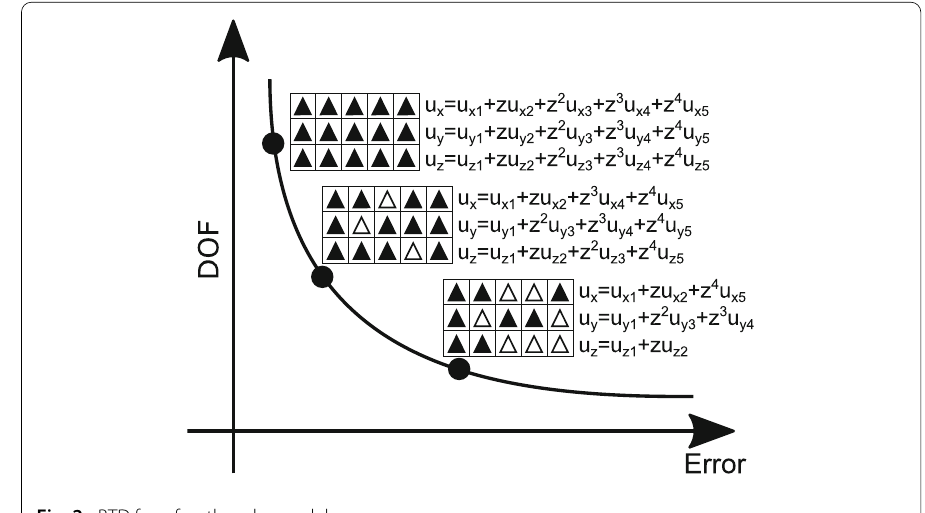
Fig. 2 BTD for a fourth-order